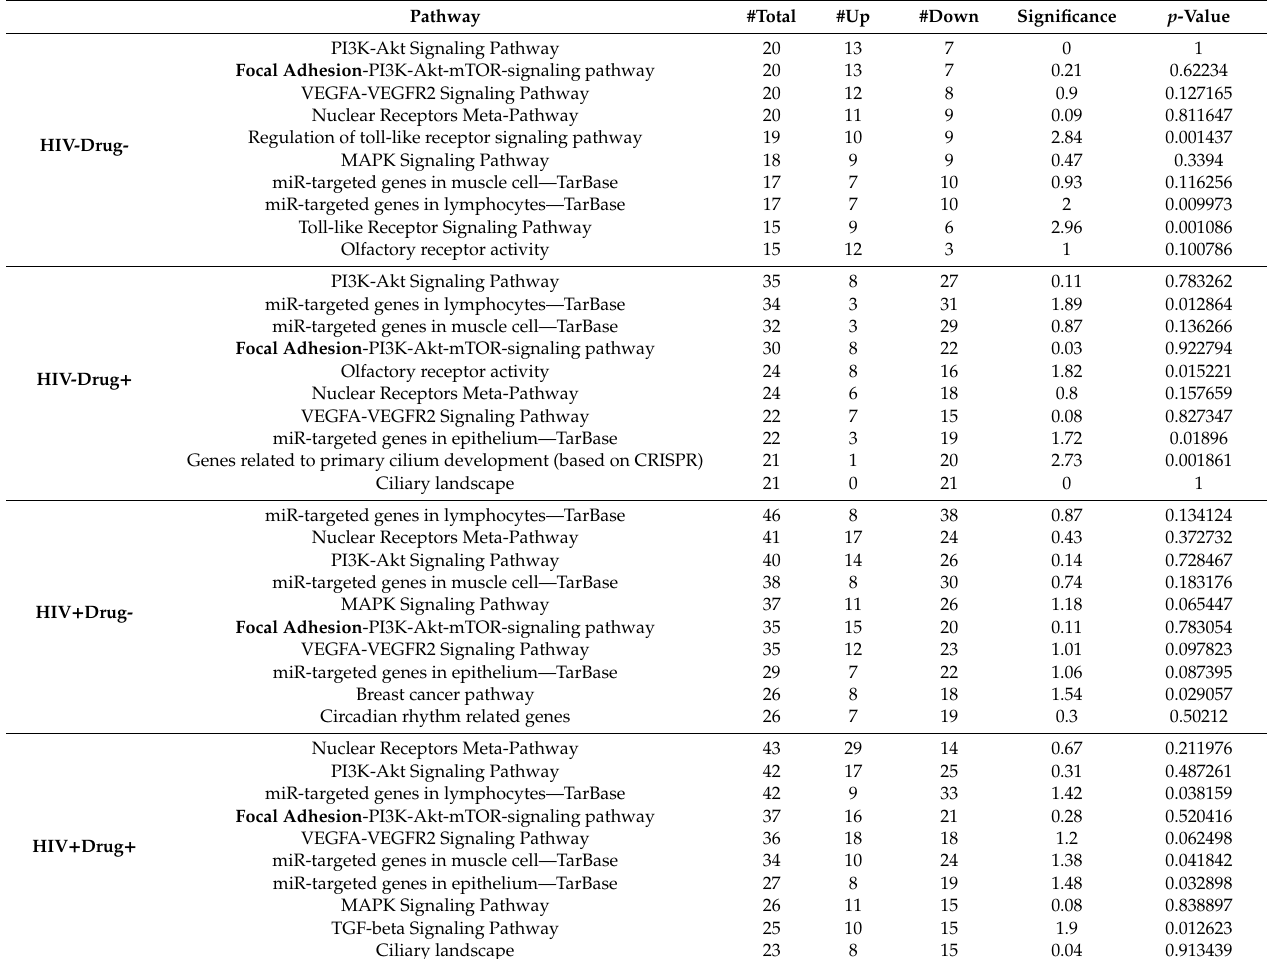
Table 8. Top 10 KEGG pathways by count as determined by Transcriptome Analysis Console (TAC) software 1